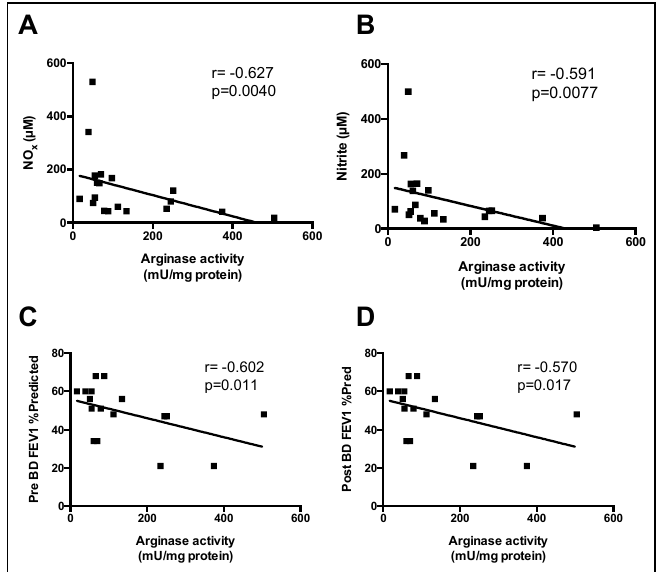
Figure 5. Arginase activity in COPD sputum correlates inversely with sputum NO and nitrite ( B ) levels, and with both pre ( C ) and post-bronchodilator ( D ) FEV Spearman’s correlation coefficient and p -values are as